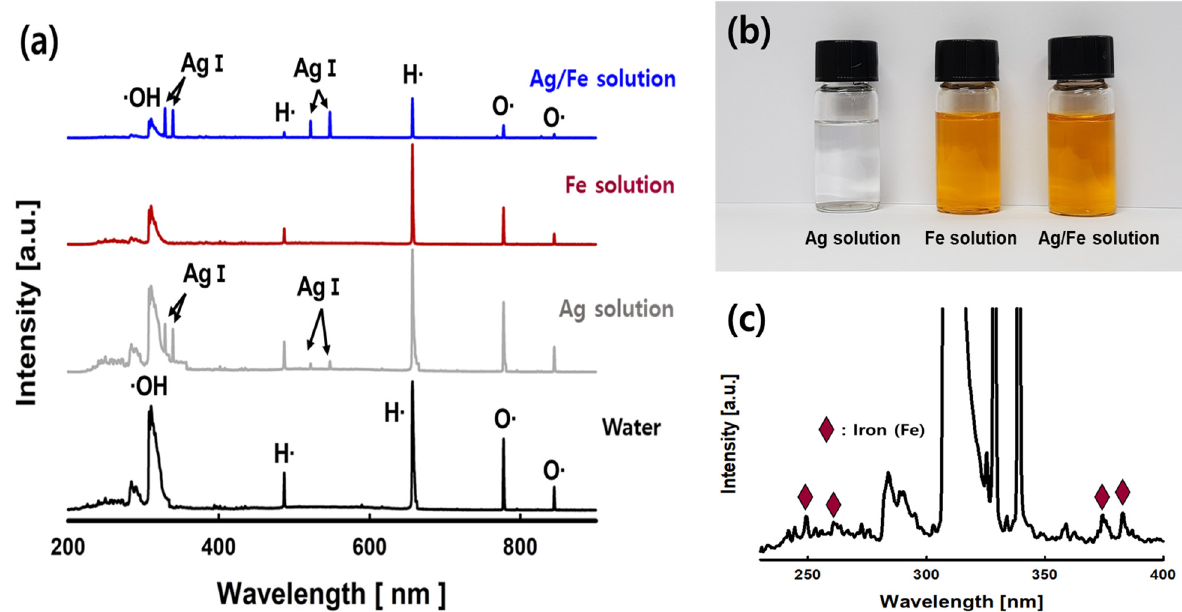
Figure 3. OES spectra of the aqueous reactant solution with metal precursors ( a ), aqueous reactant solutions after PLP reaction ( b ), and OES spectra in the range of 200–400 nm of Ag/Fe aqueous reactant solution ( c ).